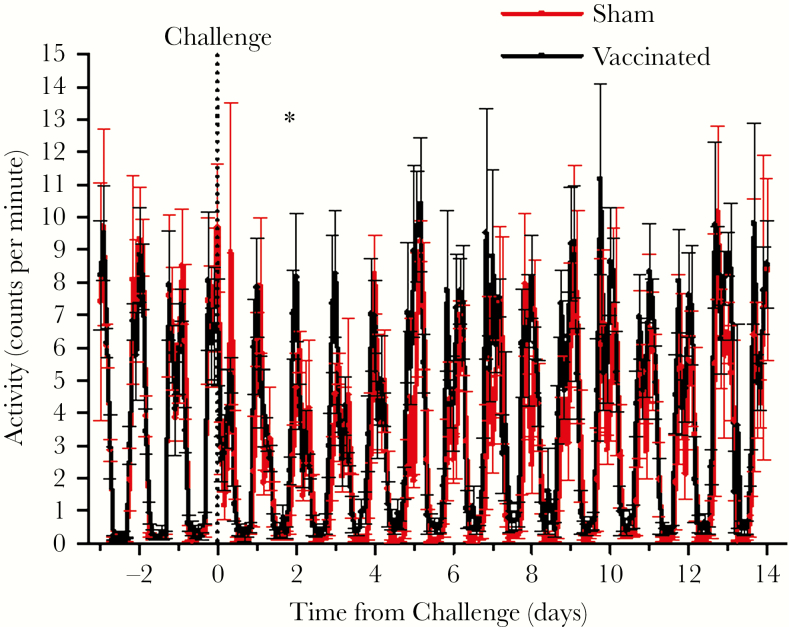
Nonhuman primate activity curves were generated using a 2-hour moving average. The vaccinated versus sham-vaccinated groups were compared statistically by one-way analysis of variance followed by Tukey’s test at each 2-hour time point beginning from 42 to 90 hours postchallenge. The mean activity of the sham-vaccinated animals was lower (P < .05) at hour 44 postchallenge as indicated by the asterisk. There are no units for activity.